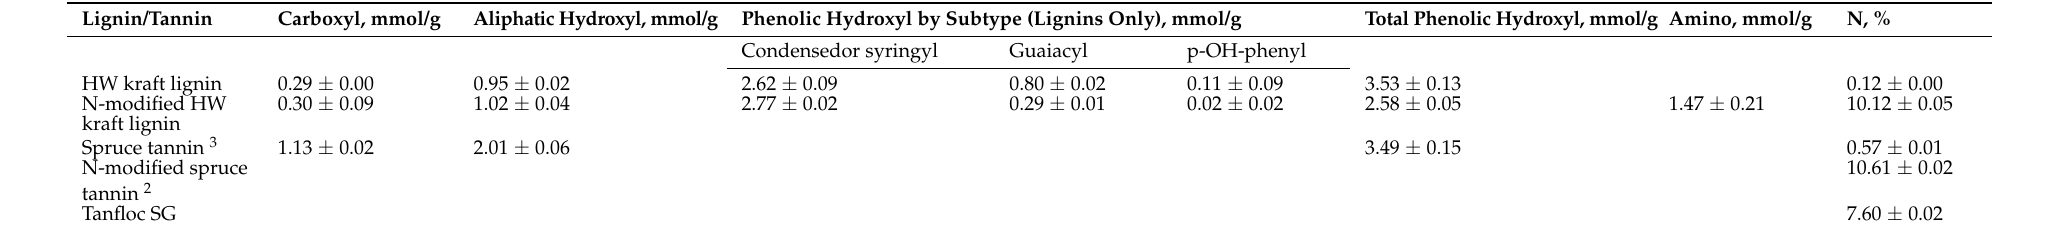
Table 1. Functional group ( 31 P NMR) and nitrogen (CHNS analysis) content of lignin 1 and